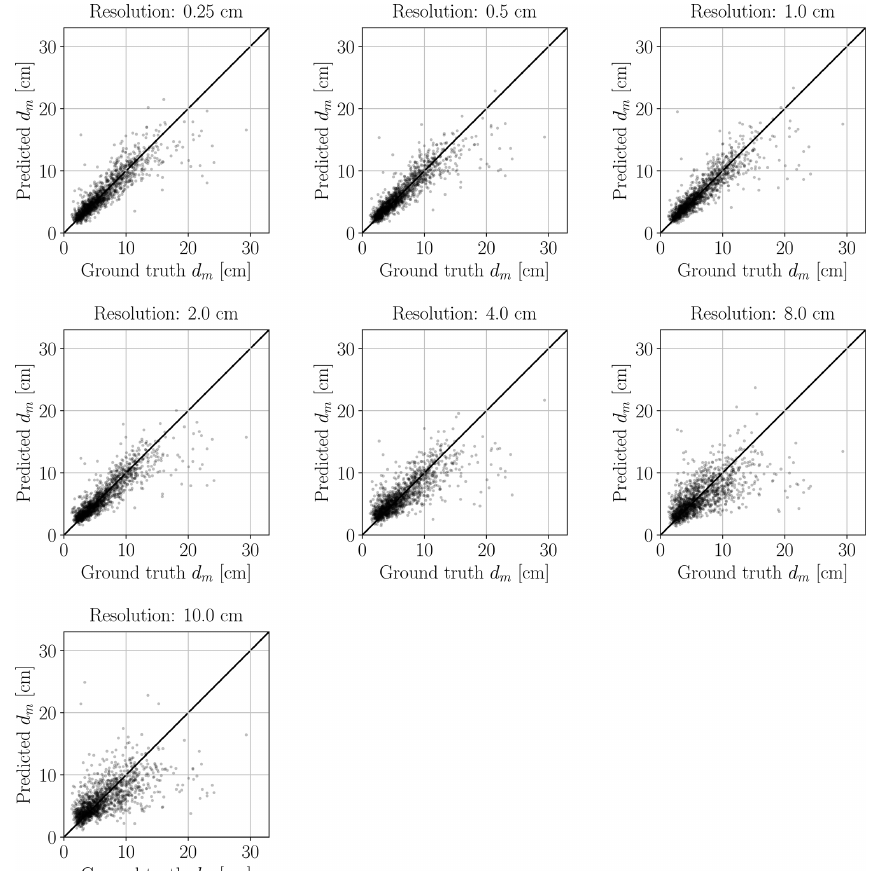
Figure E2. Scatter plots of GRAINet d m regression with different image resolutions (trained with MSE loss).